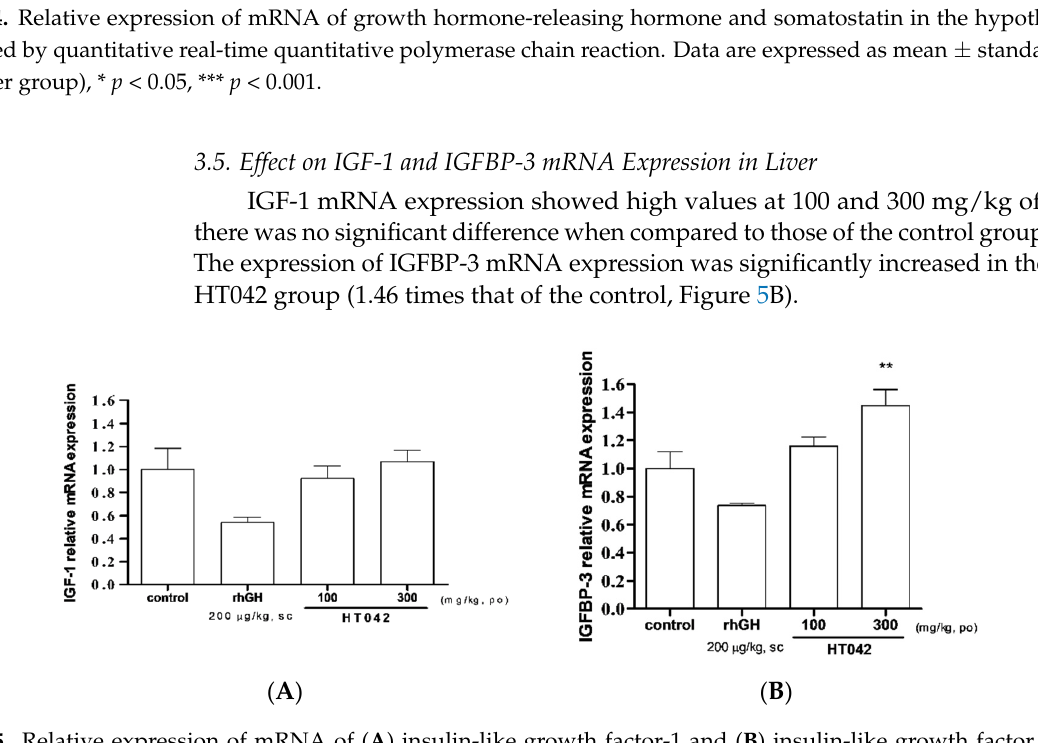
Figure 6. Representative fluorescence photographs of the proximal tibial growth plate in rats. Arrows imply the distance of bone growth in proximal tibia for 72 h period, ( A ) Control, ( B ) rhGH 200 µg/kg (s.c.), ( C ) HT042 100 mg/kg (p.o.), ( D ) HT042 300 mg/kg (p.o.). Scale bar; 200 µm.